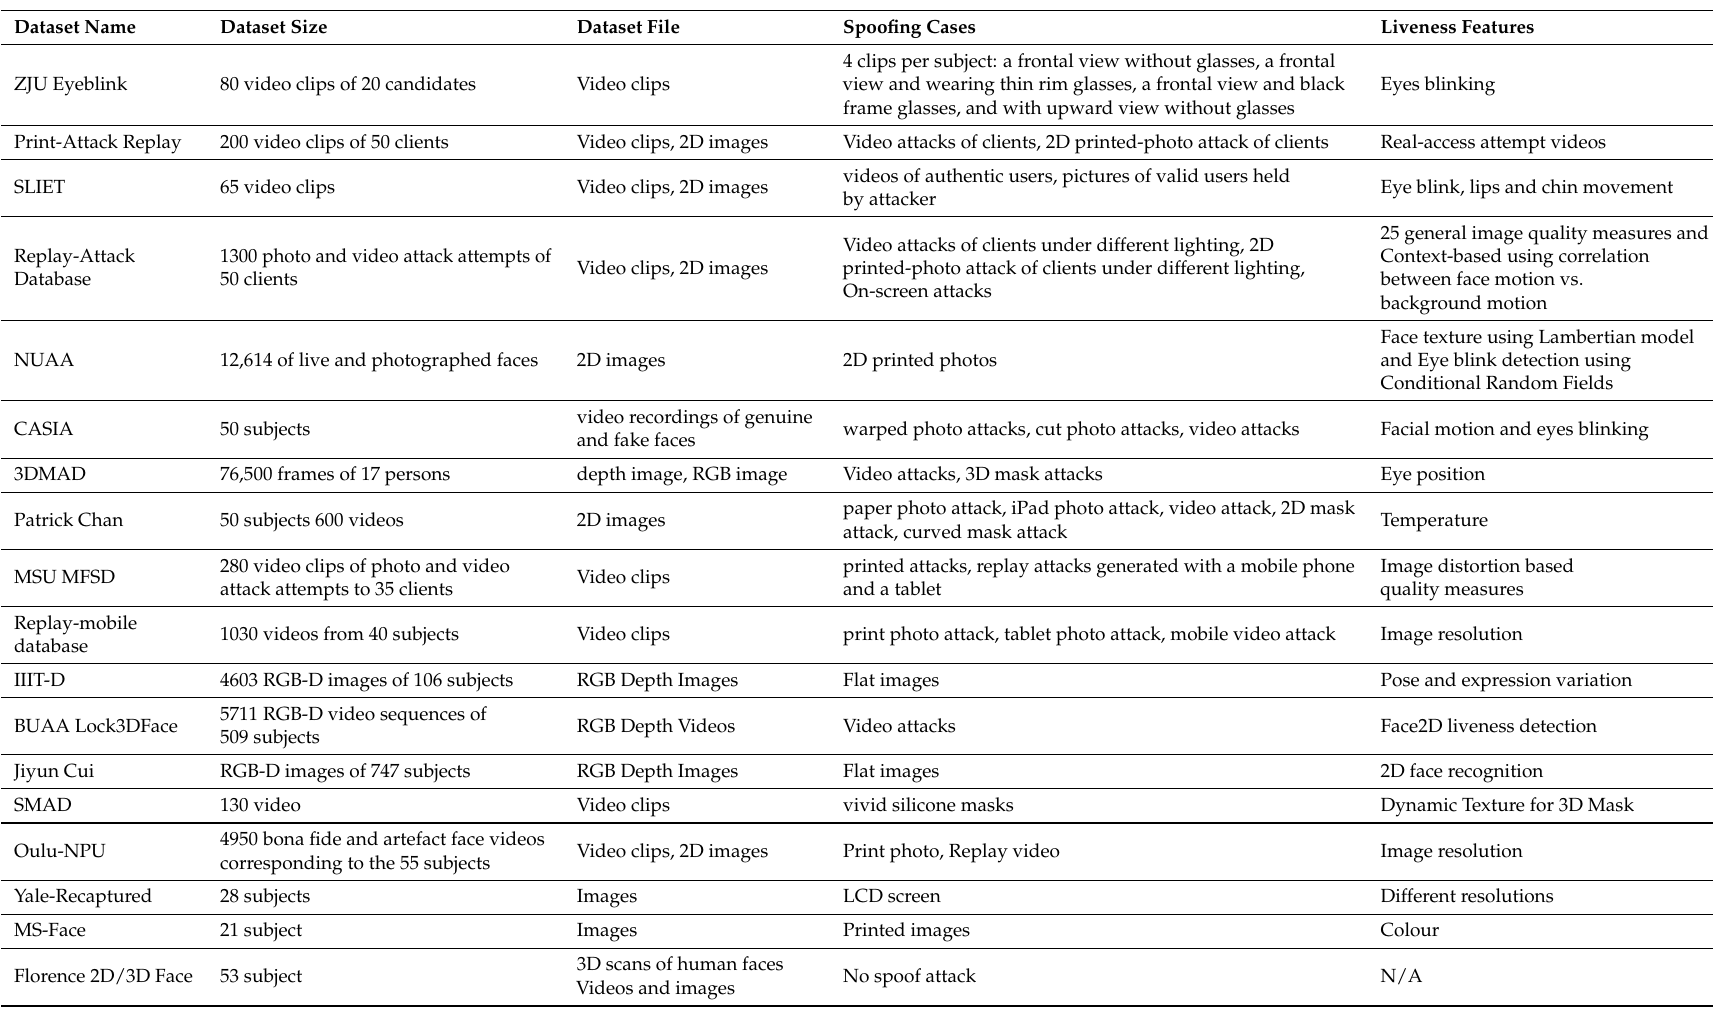
Table 1. List of face authentication public